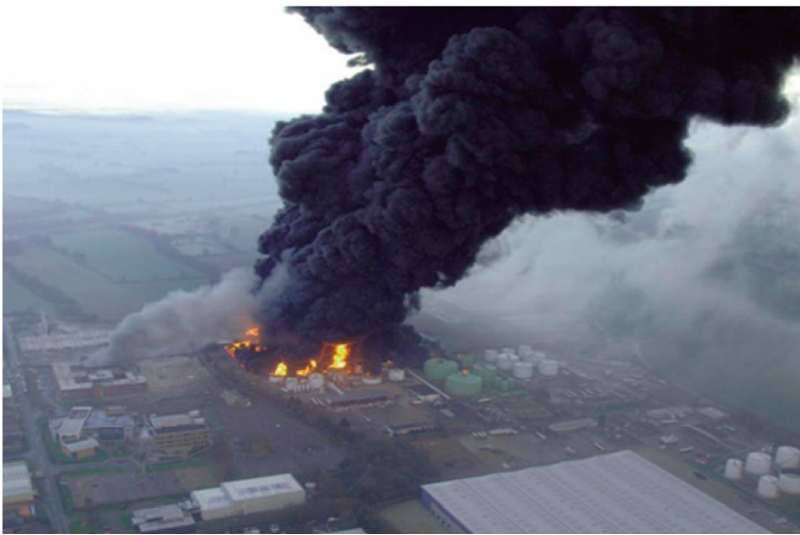
Figure 2. The fire and explosion of the Donghuang oil pipeline.